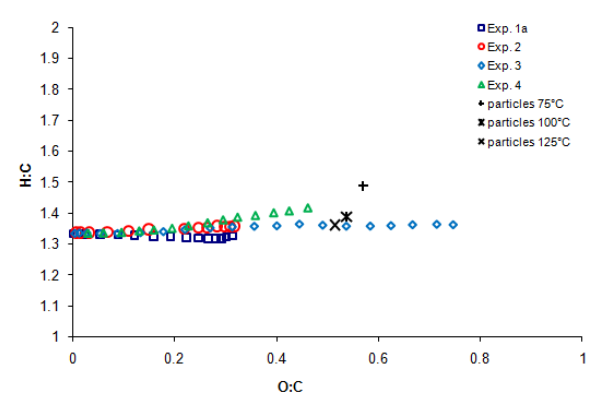
Fig. 9. Van Krevelen diagram including data from experiments 1a, Figure 9. Van Krevelen diagram including data from experiments 1a, 2, 3 and 4 (gas phase) 2 2, 3 and 4 (gas phase) and experiment 1b and experiment 1b (SOA). 3